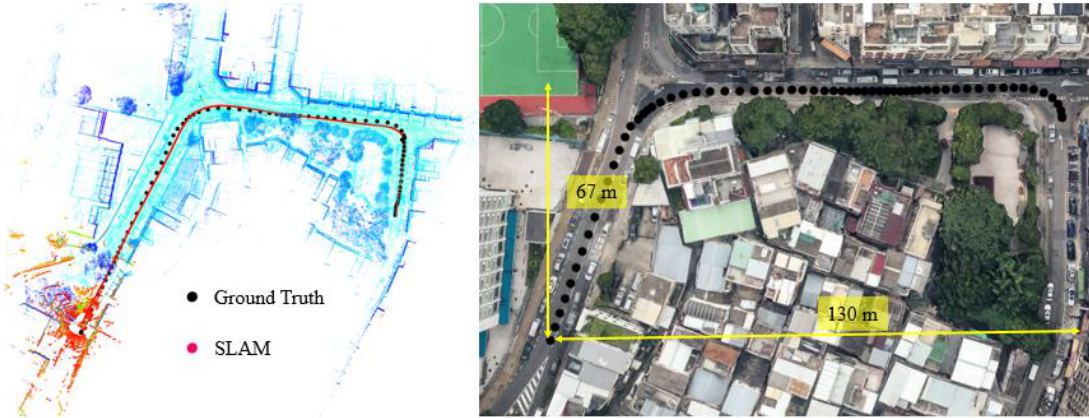
Figure A1. Experiment 5: the trajectory of NDT-based graph SLAM in a sub-urban area with normal traffic condition. The left panel indicates the generated points map and trajectory from SLAM. Right panel represents the snapshot in Google Maps. The black curve indicates the ground truth of the vehicle’s trajectory.